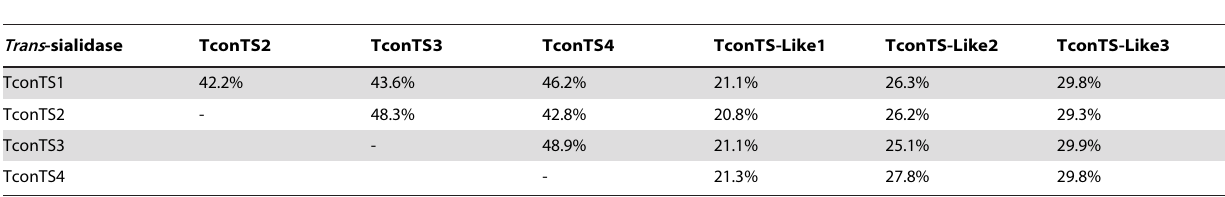
Table 1. Trypanosoma congolense trans -sialidase sequence similarities expressed as percentage of identical amino acids in pair- wise